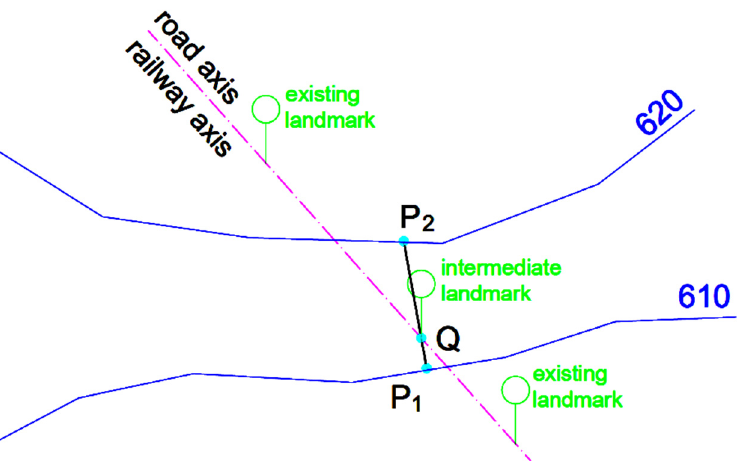
Figure 1. Finding the slope at a point using level curves.